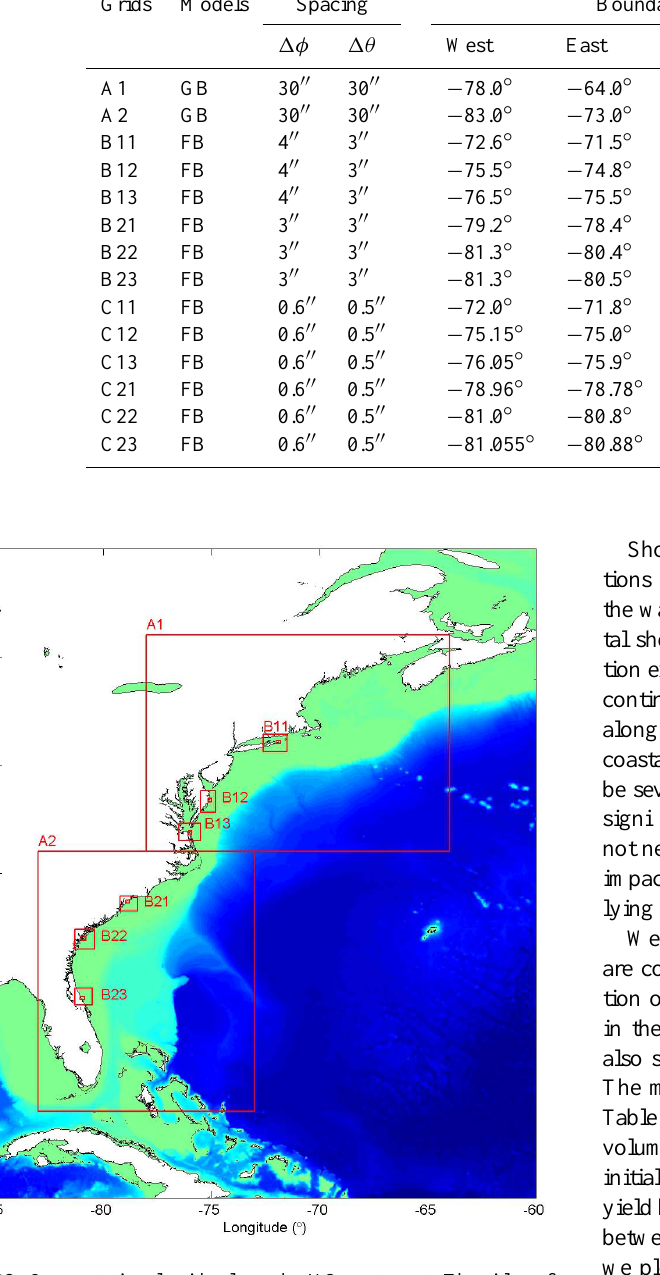
Fig. 22. Computational grids along the US east coast. The titles of C-level grids adopt the numbers from those nesting on B-level, but not marked in this figure.